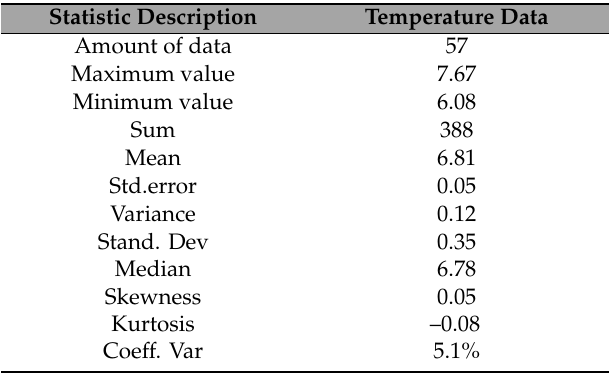
Table 2. Annual average minimum temperature summary statistics.